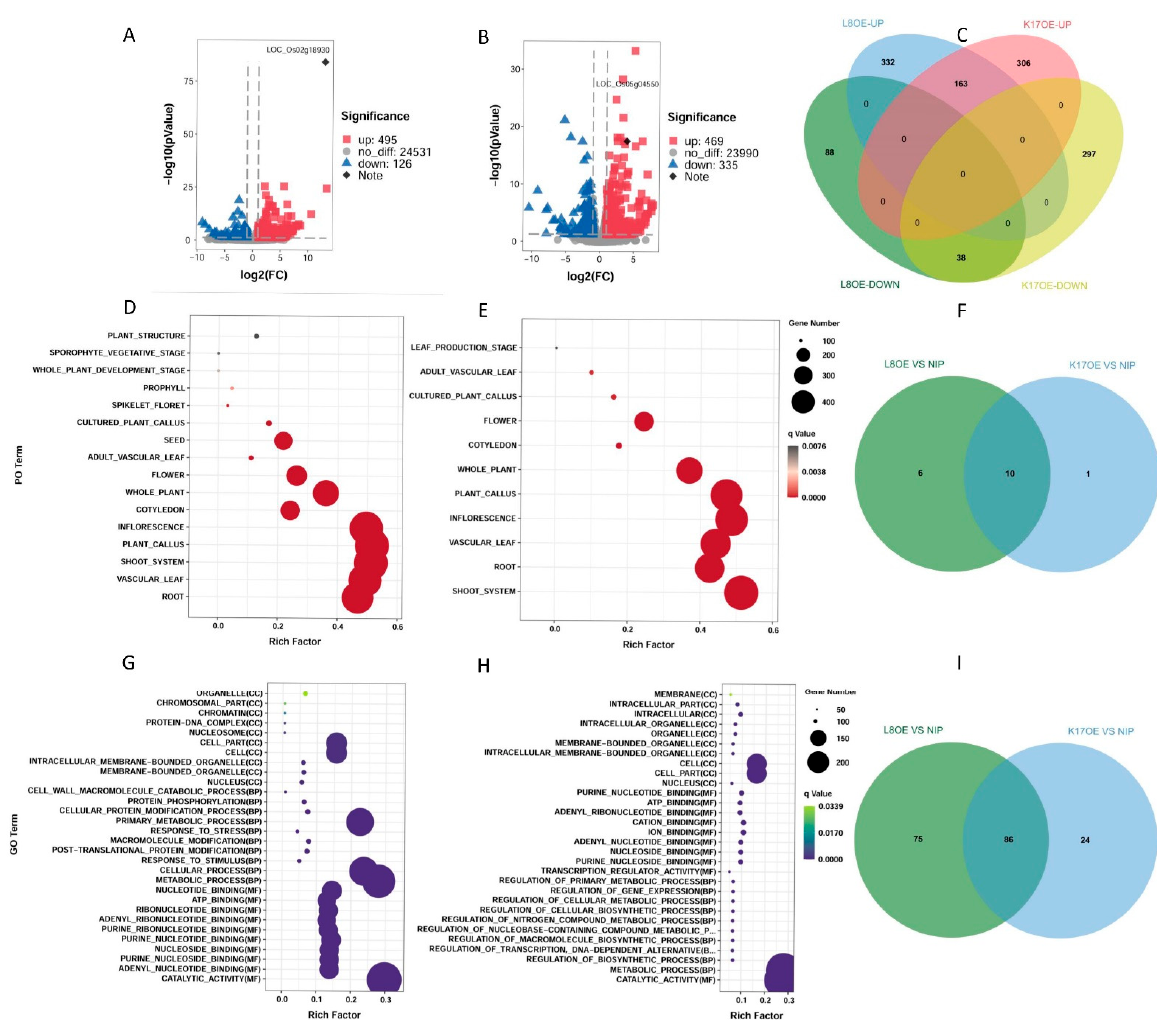
Figure 4. Transcriptome analysis of OsCBL8 and OsCIPK17 overexpressing lines. ( A ) Volcano map showing the changes in gene expression in overexpression lines of OsCBL8 and NIP. ( B ) Volcano map showing the changes in gene expression in overexpression lines of OsCIPK17and NIP. OsCBL8 and OsCIPK17 are marked with a diamond. ( C ) Venn diagram showing the intersection of up- and downregulated differentially expressed gene (DEG) sets. ( D ) Plant Ontology (PO) enrichment analysis of OsCBL8 overexpression lines. ( E ) Plant Ontology (PO) enrichment analysis of OsCIPK17 overexpression lines. ( F ) The Venn diagram is used to show the common terms produced by different PO enrichment analysis. ( G ) Gene Ontology (GO) enrichment analysis of OsCBL8 overexpression lines. ( H ) Gene Ontology (GO) enrichment analysis of OsCIPK17 overexpression lines. Only the top 10 terms from MF, BP and CC are shown. ( I ) The Venn diagram is used to show the common terms produced by different GO enrichment